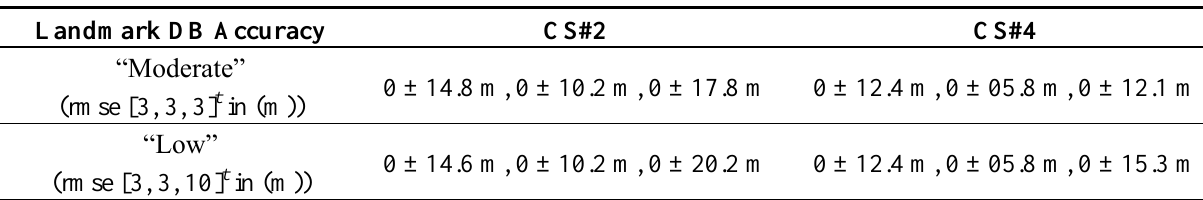
Table 4. Platform position retrieval (bias ± standard deviation of each coordinate) as a function of the settings in Table 1 and Data Base (DB) accuracy on landmark coordinates